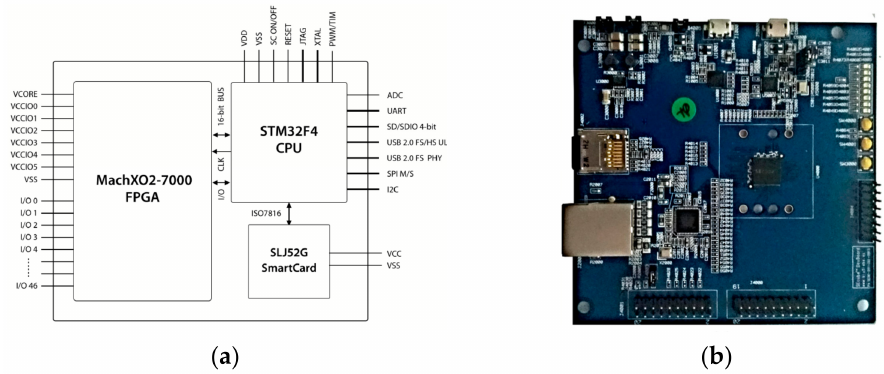
Figure 2. ( a ) SEcube™ Block Diagram. ( b ) SEcube™ Devkit.